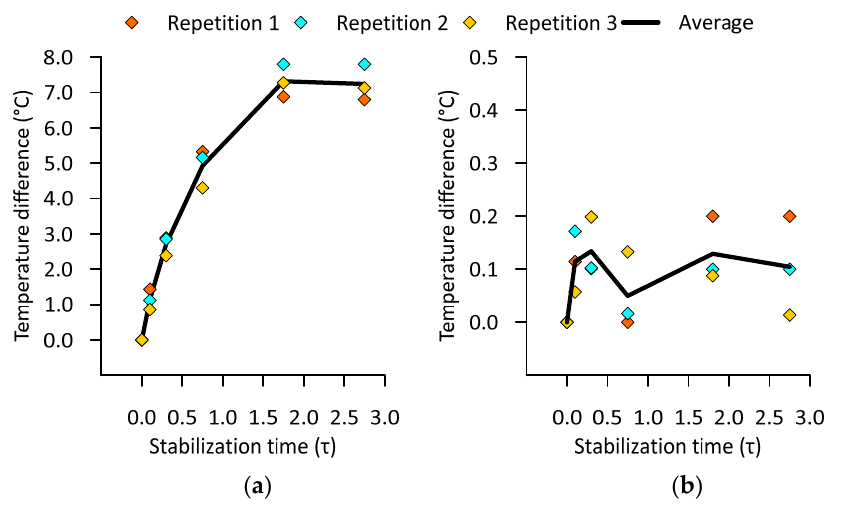
Figure 5. Temperature differences between the test water and the tracer at different locations: ( a ) Tracer container near PC and PP-1, ( b ) Tracer container near test water container away from heat- emitting equipment.